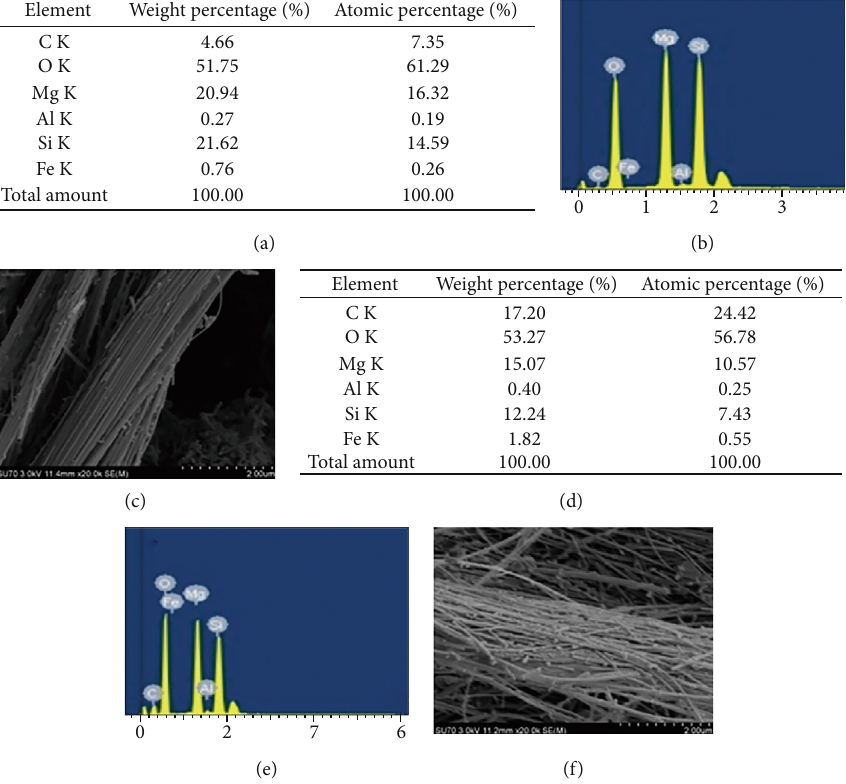
O , and (f) SEM of Sep@Fe 2 3